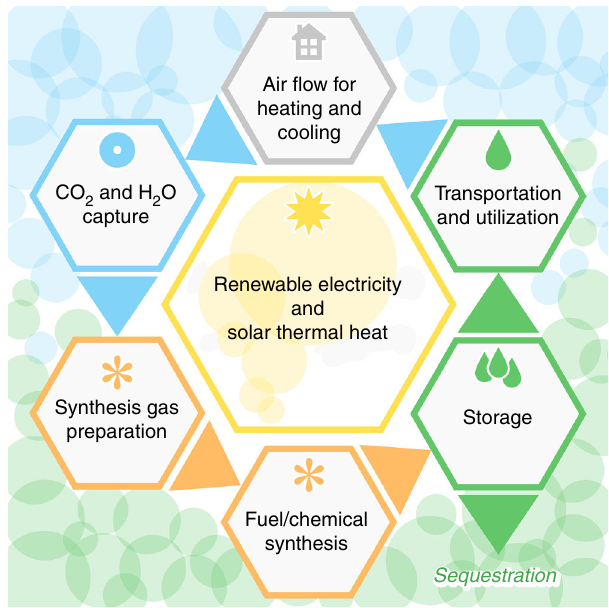
Fig. 2 Envisioned modular, on-site renewable hydrocarbon synthesis system based on CO 2 capture from thin air. Counterclockwise from